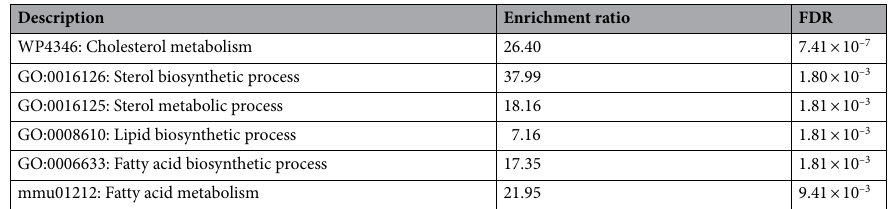
Table 3. Pathway analysis using overrepresentation analysis (ORA) on genes significantly-affected in both Tmem135 FUN025/FUN025 versus WT eyecup RNA-Seq and GSE29801 and GSE135092 datasets*. *FDR cut-off of 0.01 is used for